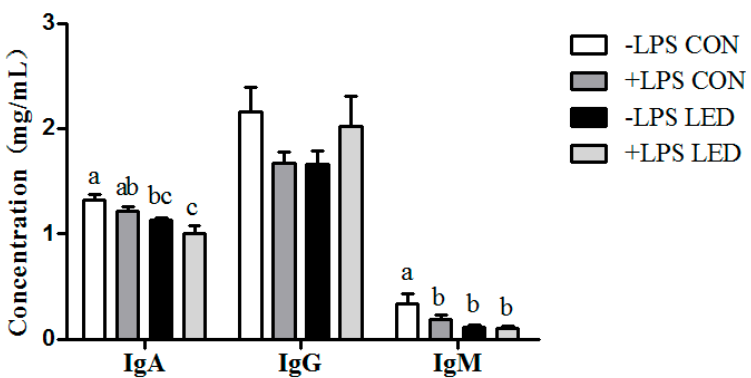
Figure 6. Effect of different energy levels during gestation on plasma immunoglobulin concentrations of weaned piglets challenged with Escherichia coli lipopolysaccharide. Values are expressed as mean values with their standard errors; means with different superscript letters are significantly different ( p < 0.05); the replicated number of each group is 6.